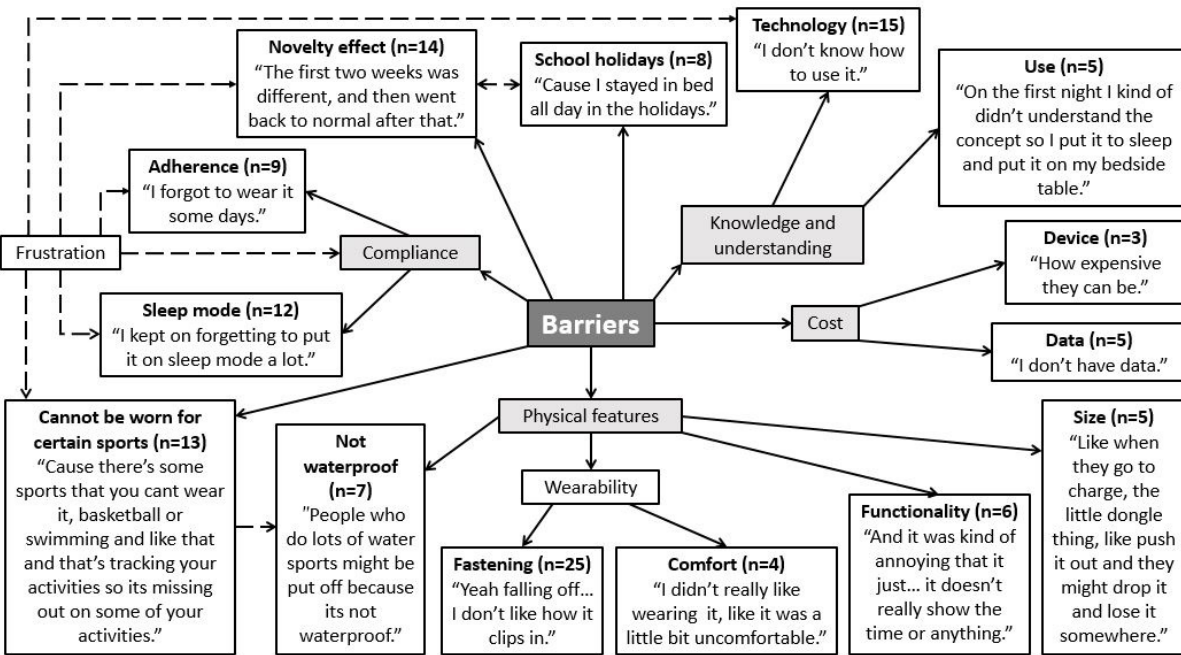
Figure 3. Adolescent’s barriers to Fitbit use. The dashed line indicates link made between different themes was noted by the researchers from the points discussed, rather than directly mentioned by the